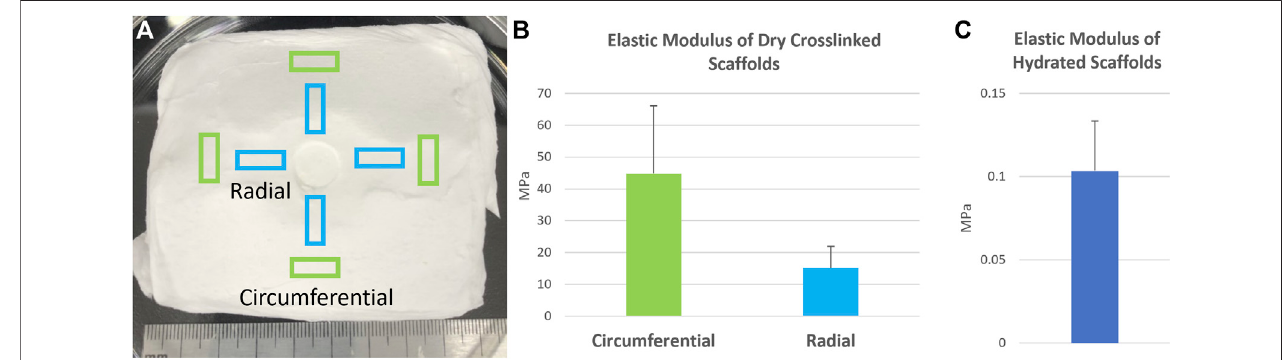
FIGURE 2 | Mechanical properties of pneumatospun collagen scaffolds deposited upon a spinning mesh collector. (A) Scaffold specimens were harvested from the mesh collector in either in the circumferential or radial directions in relation to the rotation of the scaffold. (B) Elastic modulus of dry collagen scaffolds after glutaraldehyde crosslinking and (C) following hydration in medium. Error bars represent standard deviations.